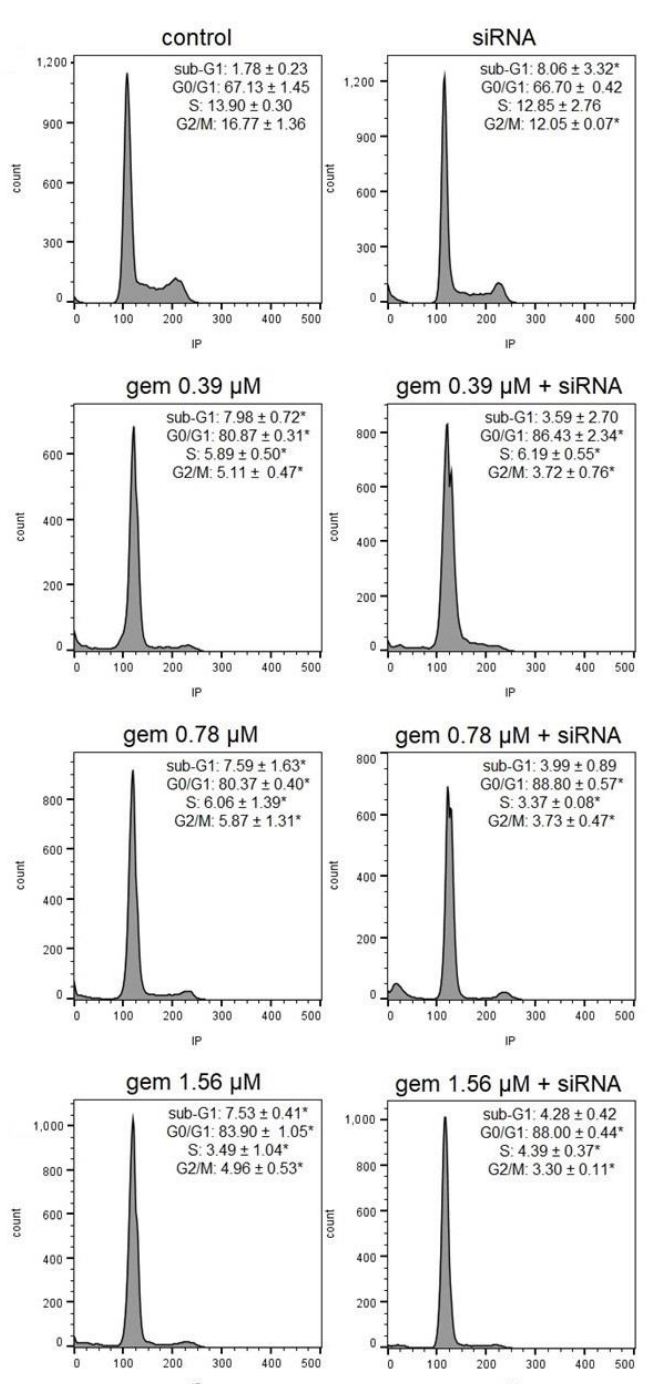
Figure 5. Representative histograms and percentages of J82 cells in each phase after treatment with gemcitabine, siRNA JHDM1D-AS1 , or gemcitabine combined with siRNA JHDM1D-AS1 . Control: untreated cells; gem: gemcitabine; IP: propidium iodide. * p < 0.05 compared to control. Similarly, in the UM-UC-3 cell line, there was mild cell cycle arrest at the G0/G1 phase in the cells treated with all concentrations of gemcitabine and with gemcitabine and siRNA JHDM1D-AS1 . The combined treatment led to a significant increase in cell popu- lations in the S phase, when compared to cells treated solely with the respective gemcita- bine concentrations and to the untreated control. Additionally, an increase in the sub-G1